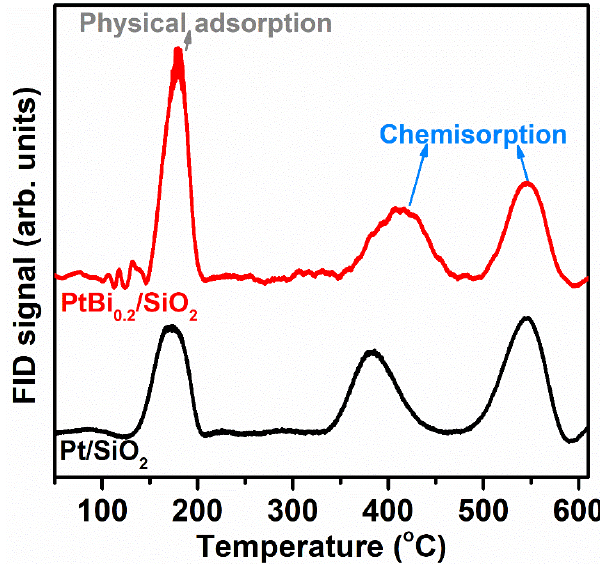
Figure 8. TPD curves of cyclohexanone on Pt/SiO 2 and PtBi 0.2 /SiO 2 .